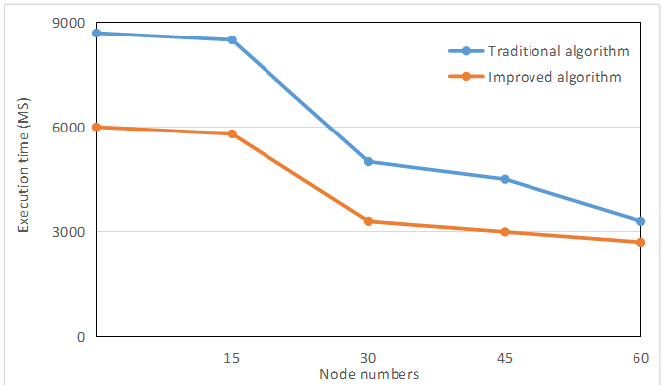
Figure 6. Execution curve for different node numbers.